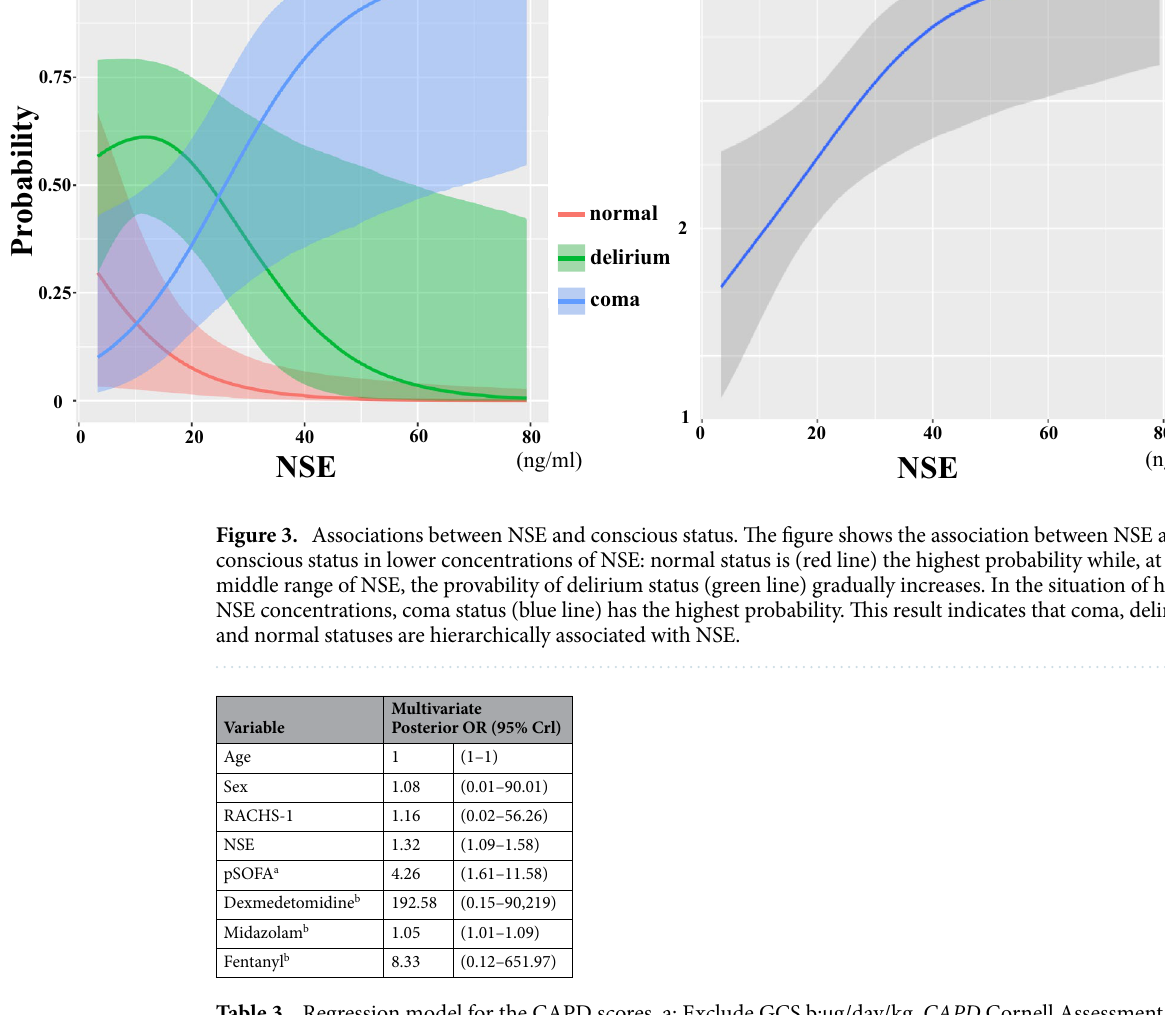
Table 3. Regression model for the CAPD scores. a: Exclude GCS b:μg/day/kg. CAPD Cornell Assessment of Pediatric Delirium, Crl credible interval, OR odds ratio, RACHS‑1 Risk Adjustment in Congenital Heart Surgery, pSOFA pediatric Sequential Organ Failure